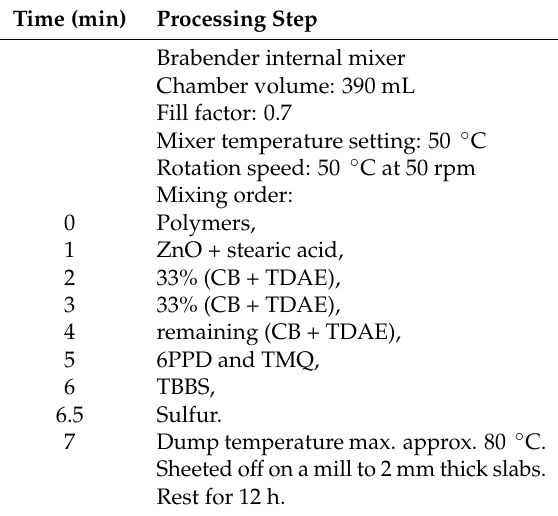
Table 9. Compounding procedure for carbon black-based tire tread formulation. Time